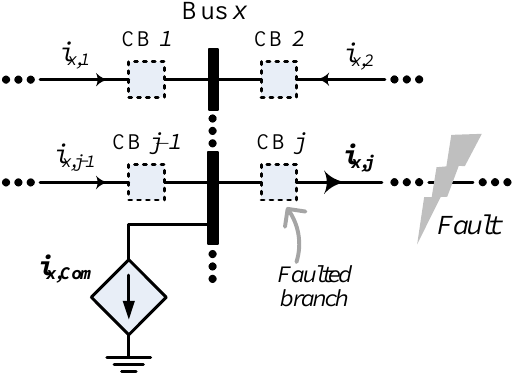
Figure 5. Current source compensator, phase x.